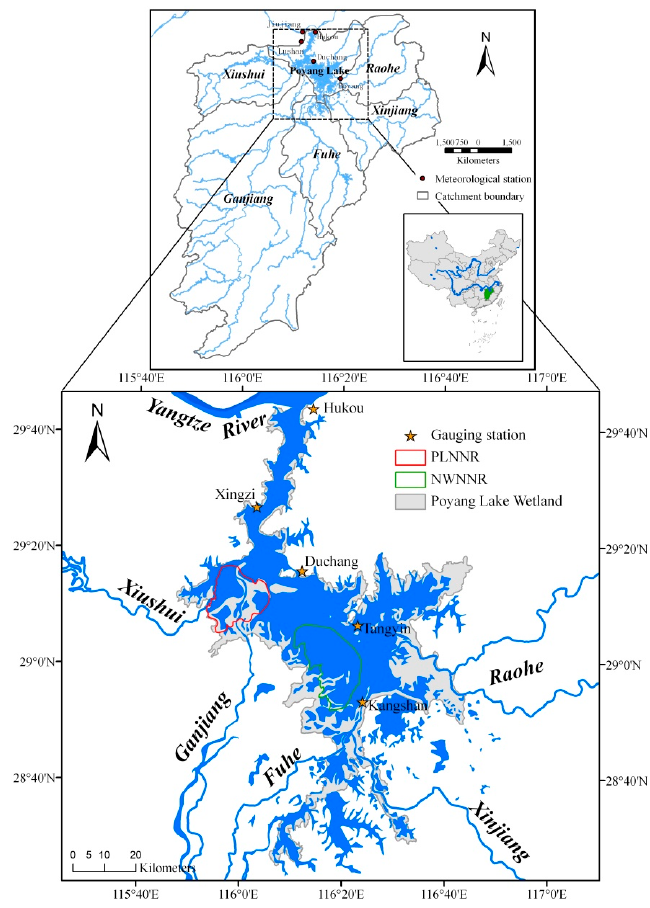
Figure 1. Locations of the Poyang Lake wetland, nature reserves, and meteorological and gauging stations. PLNNR: Poyang Lake National Nature Reserve; NWNNR: Nanji Wetland National Nature Reserve.